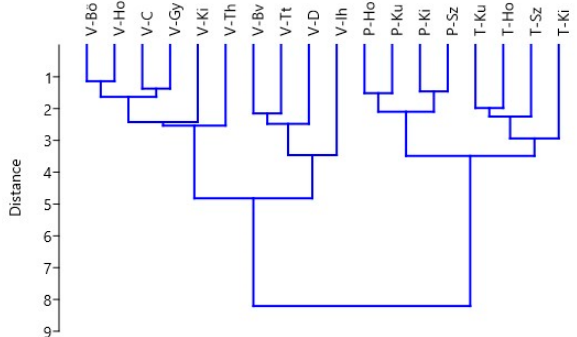
Figure 3. Classification inflorescence parameters of investigated Festuca taxa (V: F. vaginata , P: F. pseudovaginata , H: F. tomanii , Bö: Böhönye, Ho: Momoktövis TT, C: Ć enkov, Gy: Gy ő rszentiván, Ki: Kisoroszi, Th: Tahitótfalu, Vv: Balta Verde, Tt: Tatárszentgyörgy, D. Deliblato, Ih: Imrehegy, Ku: Kunpeszér, Kunadacs, Sz: Szigetszentmiklós).